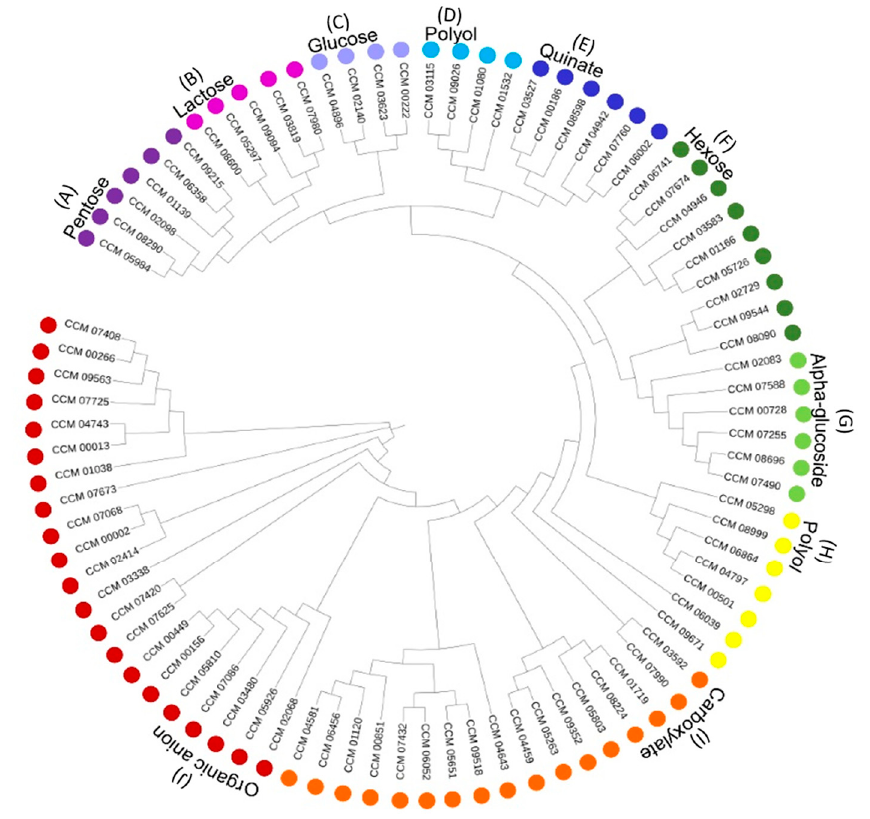
Figure 2. Phylogenetic-based classification of subfamilies of sugar transportome in C. militaris . Note: 85 sugar transporters of C. militaris were classified into nine subfamilies; ( A ) pentose (six genes); ( B ) lactose (five genes); ( C ) glucose (four genes); ( E ) quinate (six genes); ( F ) other hexose sugars (nine genes); ( G ) alpha-glucoside (six genes); ( D , H ) polyol (11 genes); ( I ) carboxylate (17 genes); ( J ) organic anion (21 genes) by sequence- and phylogenetic-based functional classification using MEGA X [25] and gene ontology (GO) [26].